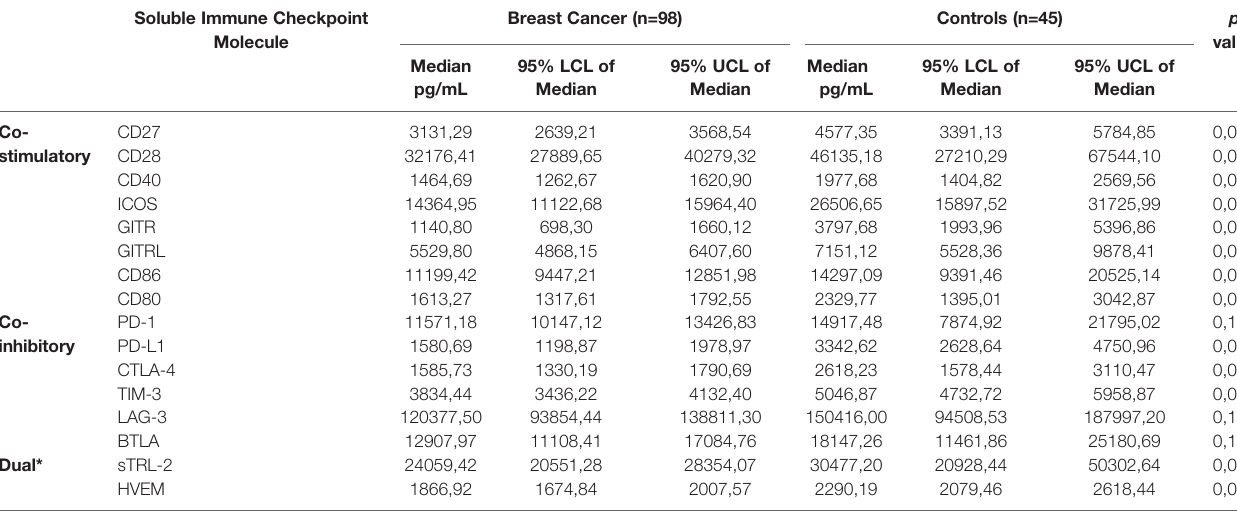
TABLE 2 | Comparison of plasma concentrations of soluble immune checkpoints between newly diagnosed breast cancer patients and healthy control subjects. Soluble Immune Checkpoint